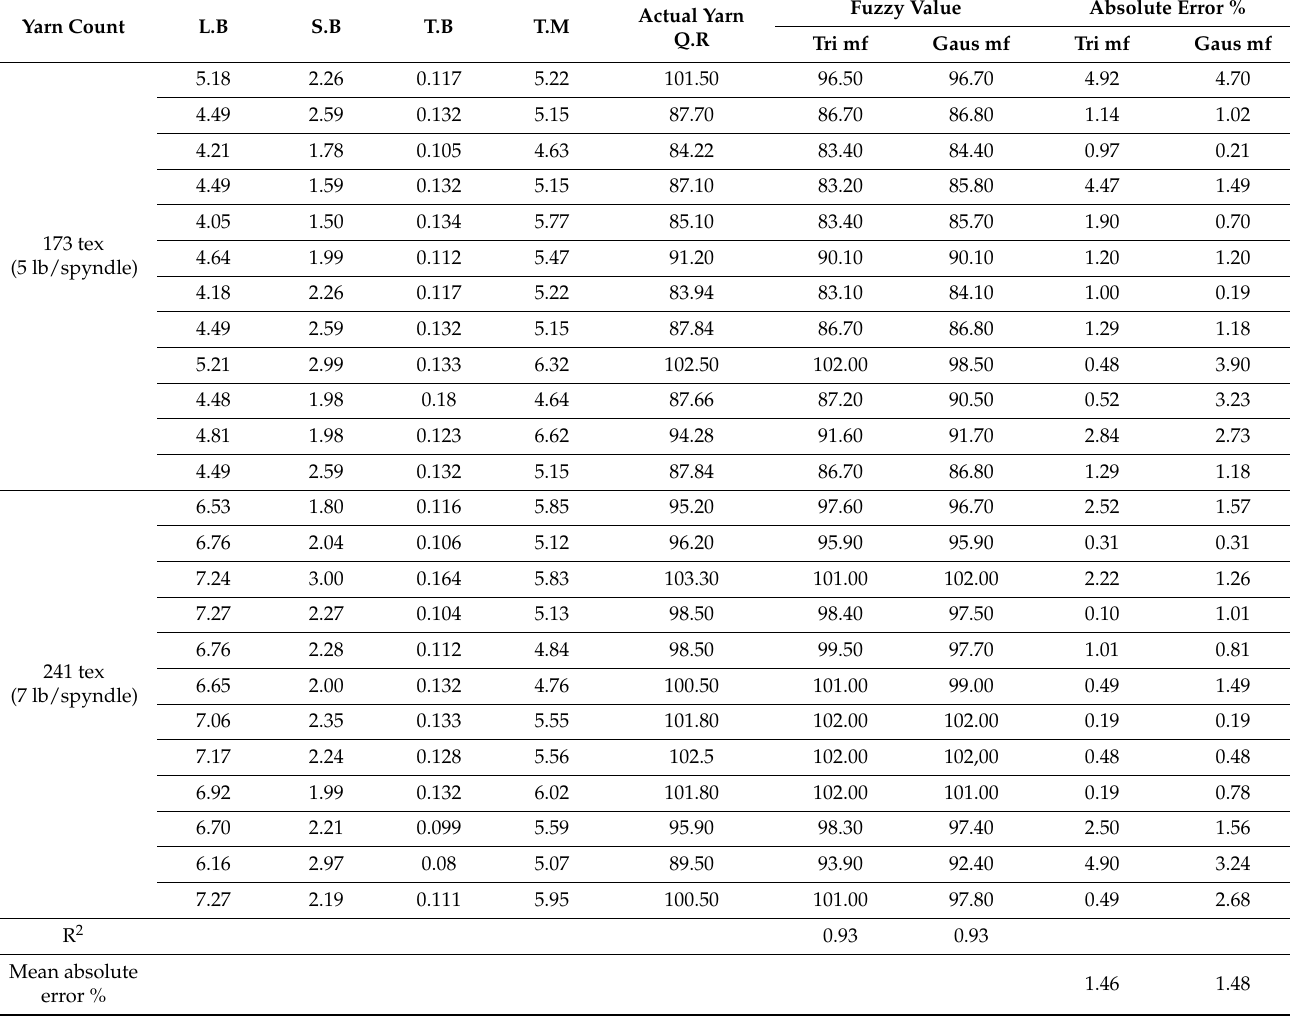
Table 3. Prediction of jute yarn strength.